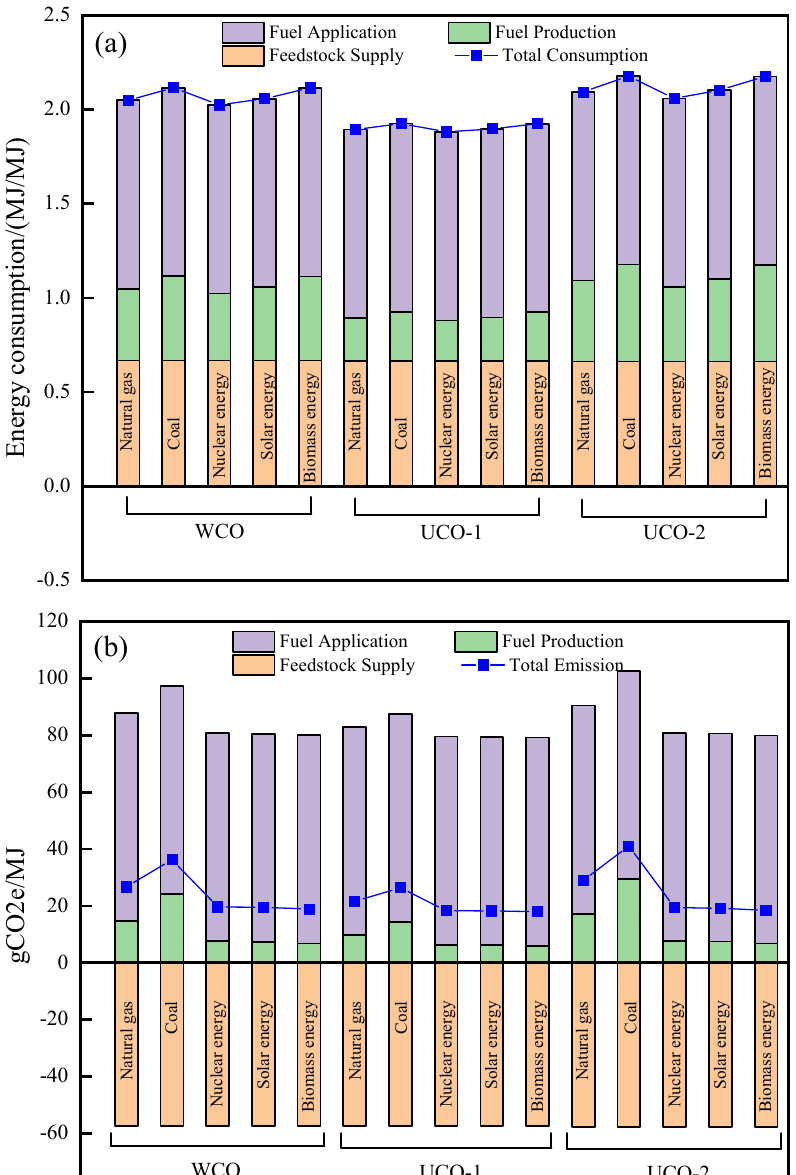
Figure 7. ( a ) Life-cycle energy consumption of different hydrogen sources. ( b ) GHG emissions from different hydrogen sources during their life-cycle.